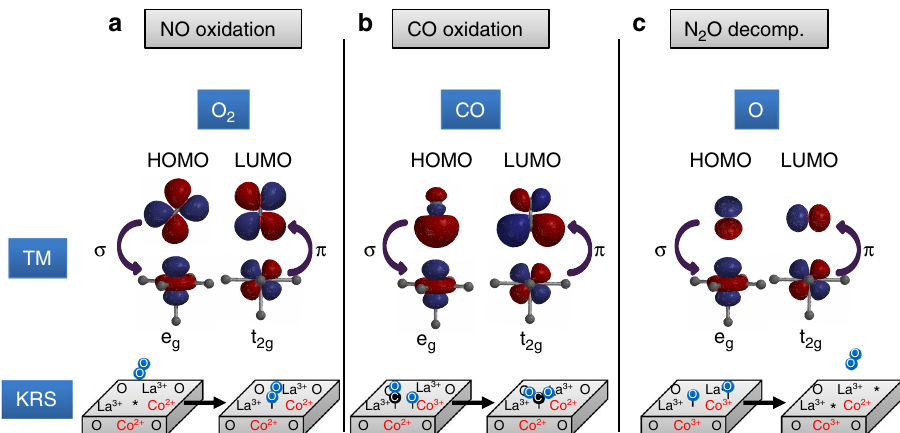
Fig. 6 Interaction of orbitals of the active site and surface species. Reactant-active-site interactions involve σ - and π -interactions of the transition metal (TM) 3 d orbitals with the highest occupied (HOMO) and the lowest unoccupied molecular orbital (LUMO) of the reactant. Orbital interactions and the respective kinetically relevant step (KRS) are shown for ( a ) NO oxidation, ( b ) CO oxidation, and ( c ) N 2 O decomposition. Please note that the depiction of the KRS does not include the complexity of binding sites on the catalyst, particularly for